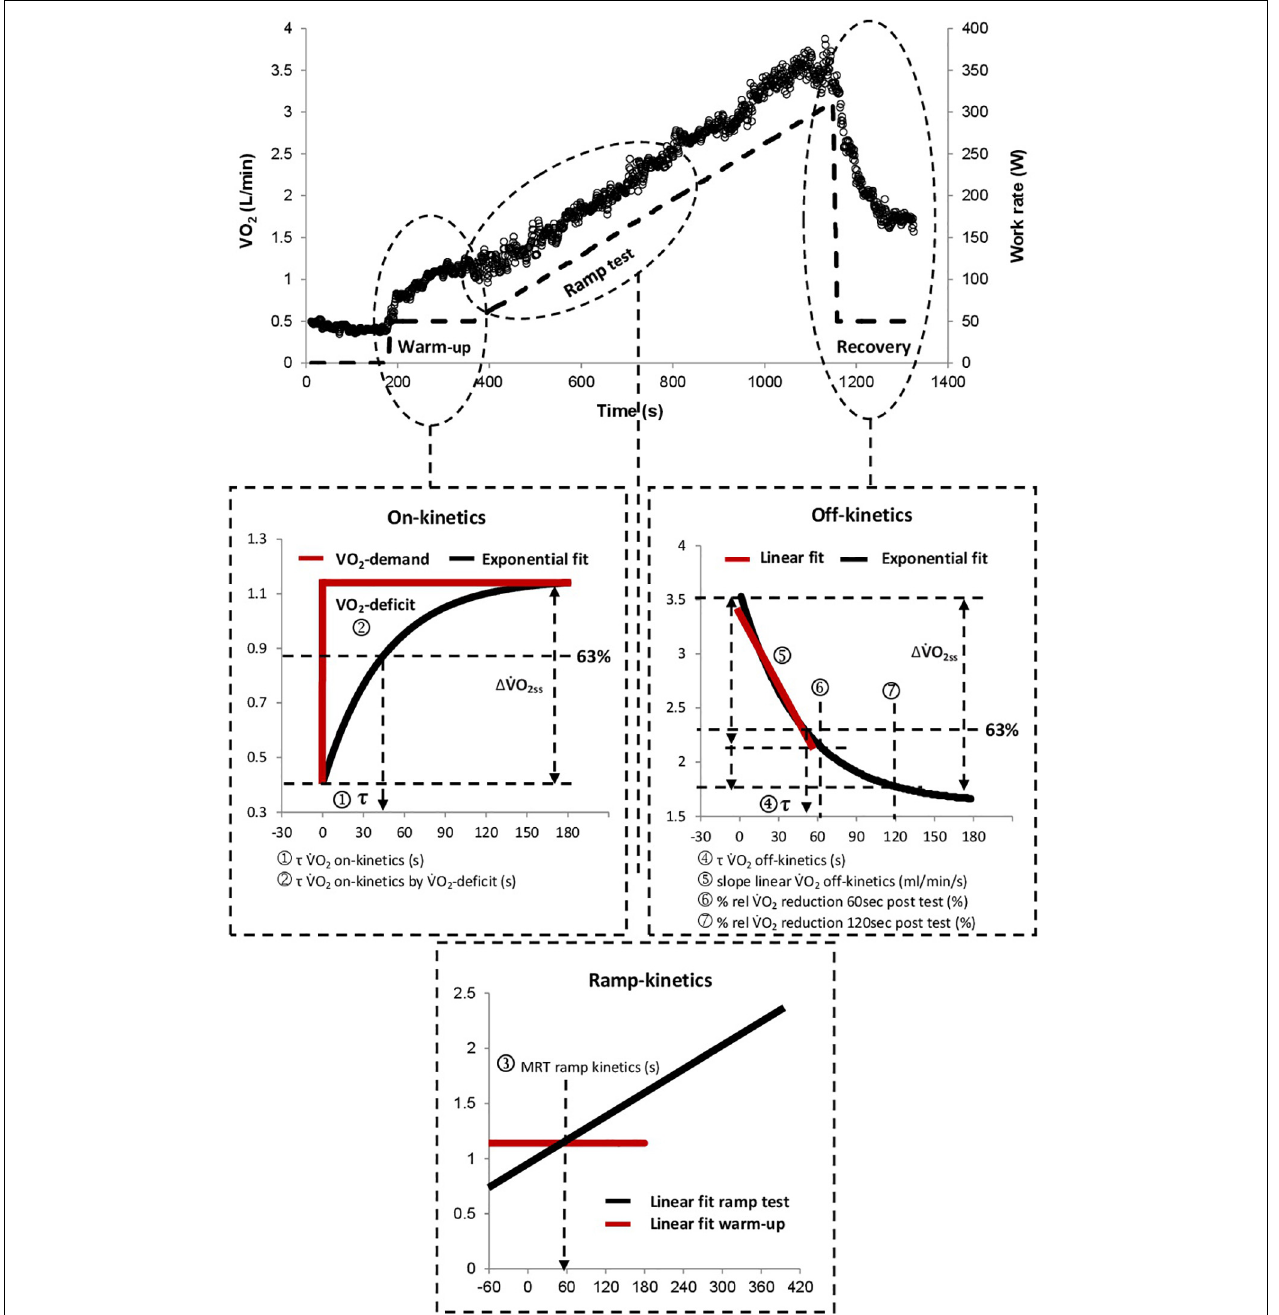
FIGURE 1 | Graphical illustration of all analyzed kinetic parameters. τ ˙VO 2 on-kinetics by ˙VO 2 -deficit was calculated by dividing the ˙VO 2 -deficit by the amplitude ( (cid:49) ˙VO 2ss ) of the ˙VO 2 response. ˙VO 2 , oxygen uptake; τ , tau; MRT, mean response time; rel,